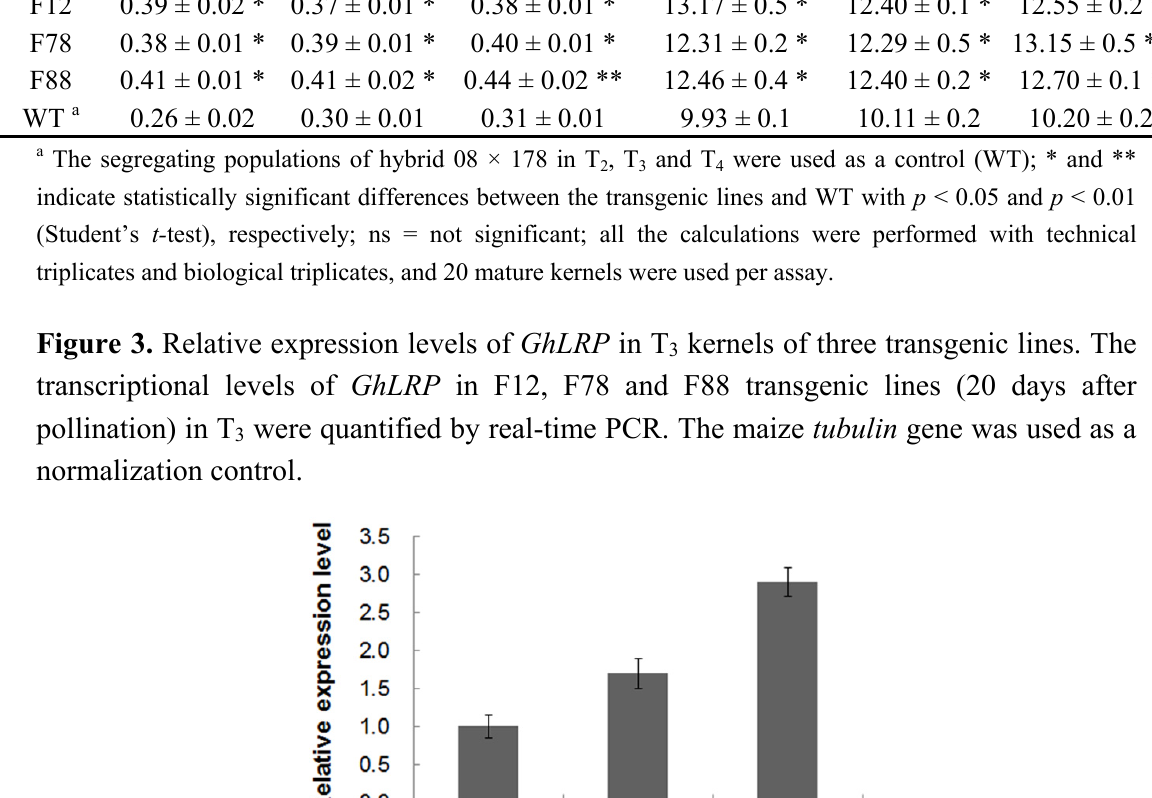
Table 2. Lysine and protein contents of T Line